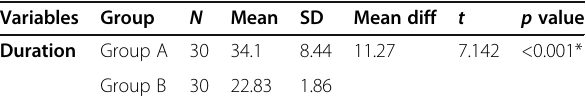
Table 1 The mean operative time in both